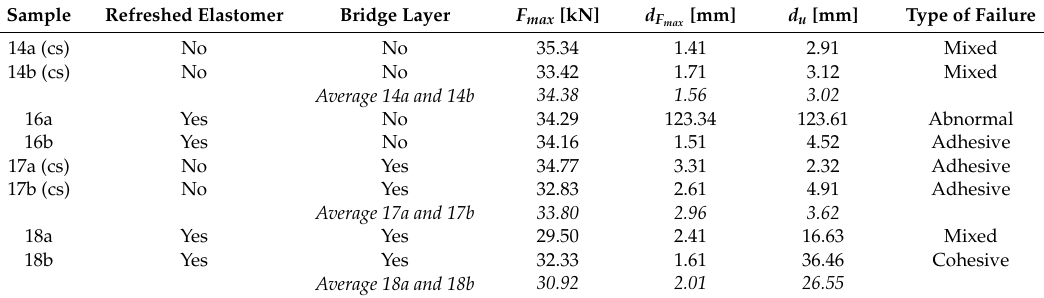
Table 6. Experimental results for samples 14a, 14b, 16a, 16b, 17a, 17b, and 17a, 16b.